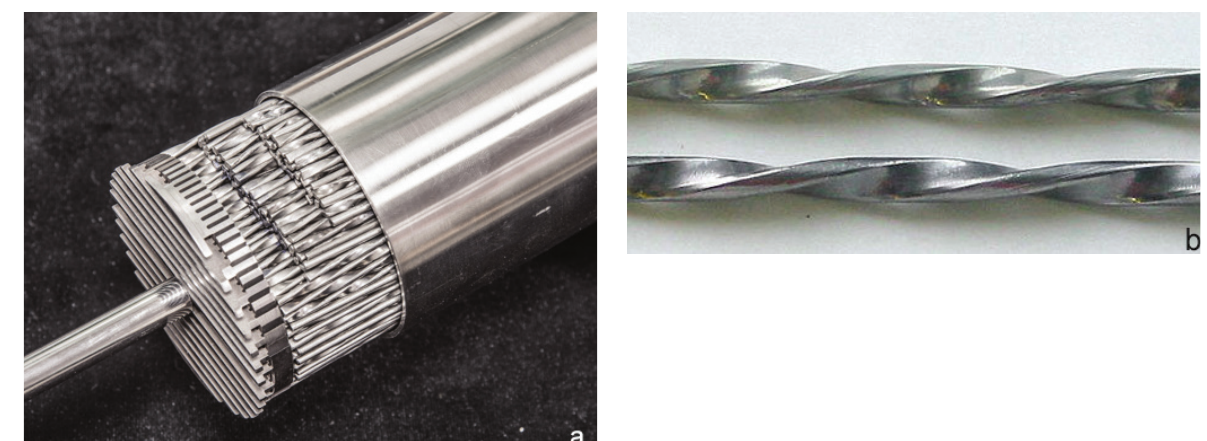
Figure 1. IVG.1M reactor fuel: a. Fuel assembly (Zhanbolatov et al. 2022); b. Fuel